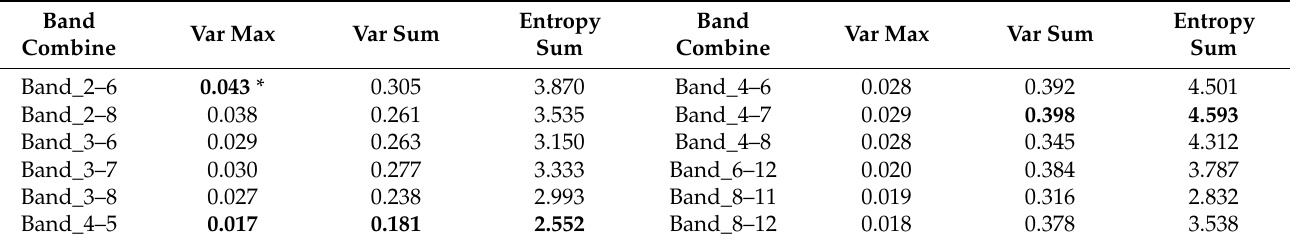
Table 6. Table of variance, entropy values.